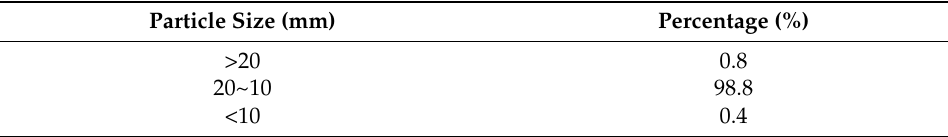
Table 2. The particle size proportion of pellets.